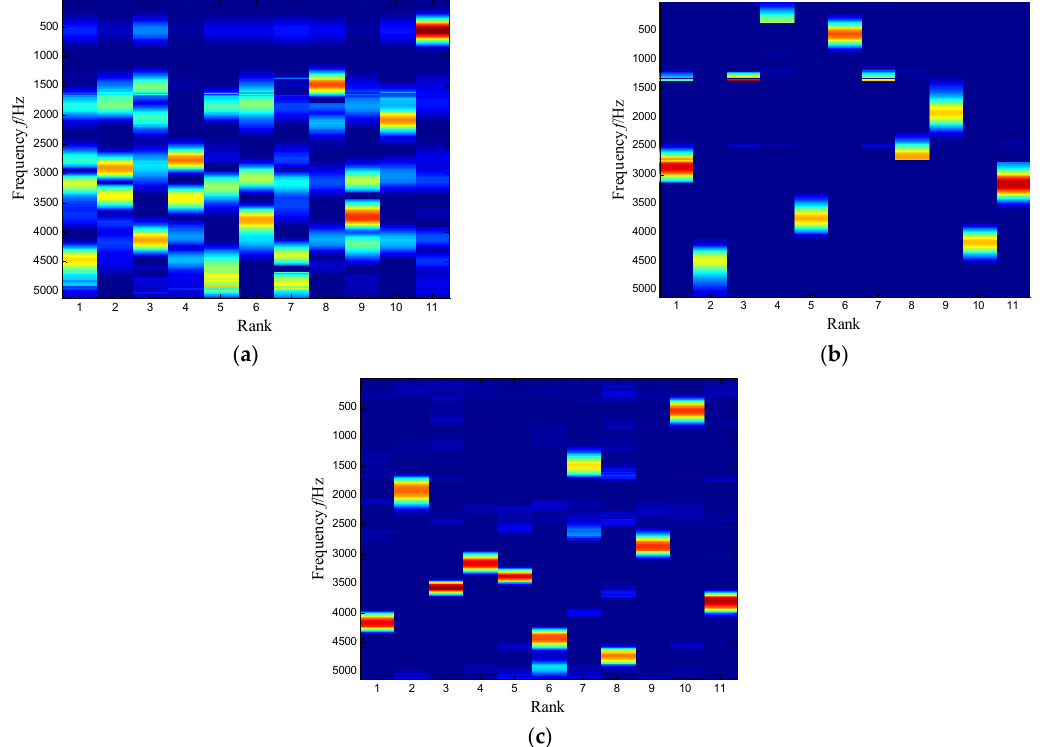
Figure 35. Coefficient matrixes with other NMF-based methods: ( a ) NMF-based, ( b ) SNMF-based and ( c )